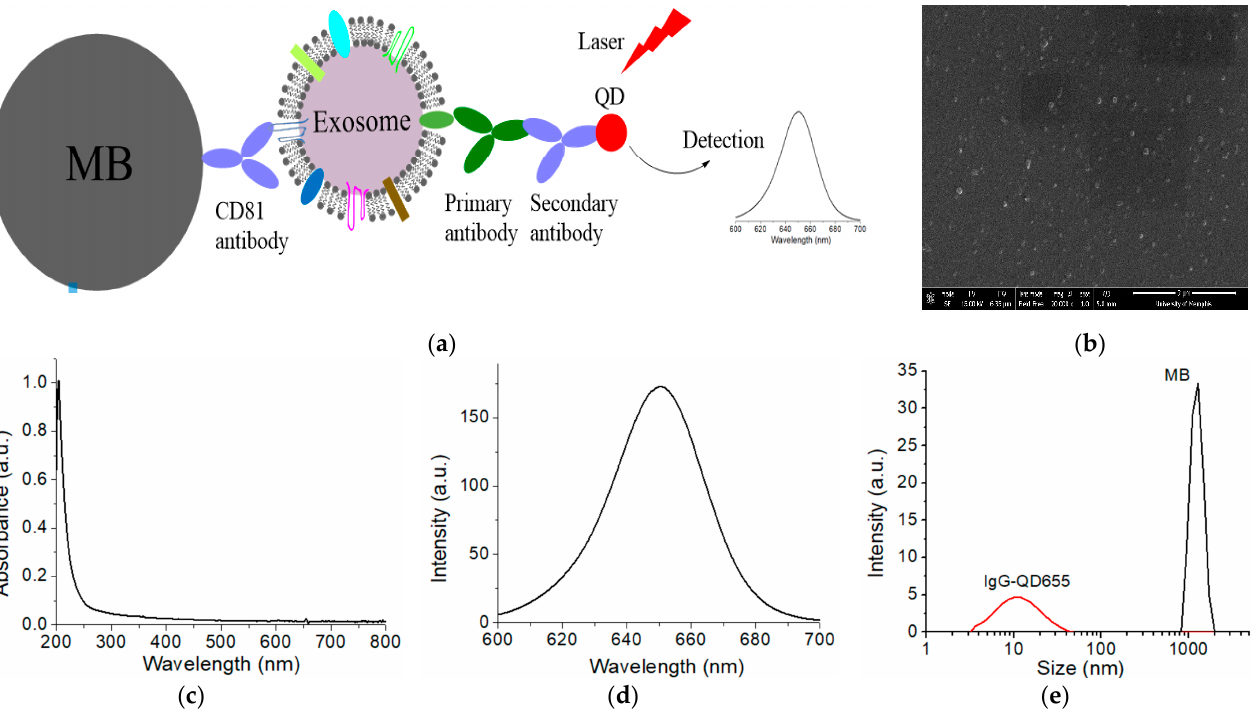
Figure 1. Schematic of the QD-based EXO assay ( a ), and characterization of EXOs ( b ), and QDs ( c–e ). EXOs were captured from biofluids with MB via CD81 monoclonal antibodies. Targeted surface cancer marker was recognized with primary antibody and then detected with secondary antibody-conjugated QD655. Signals were measured with fluorescence spectroscopy to quantify the QDs and correspondingly the surface protein markers on EXOs. ( b ) SEM image of plasma exosomes from a BC patient. ( c ) Absorption spectrum and ( d ) emission spectrum of IgG-QD655. ( e ) DLS characterization of the hydrodynamic size of IgG-QD655 and MB.